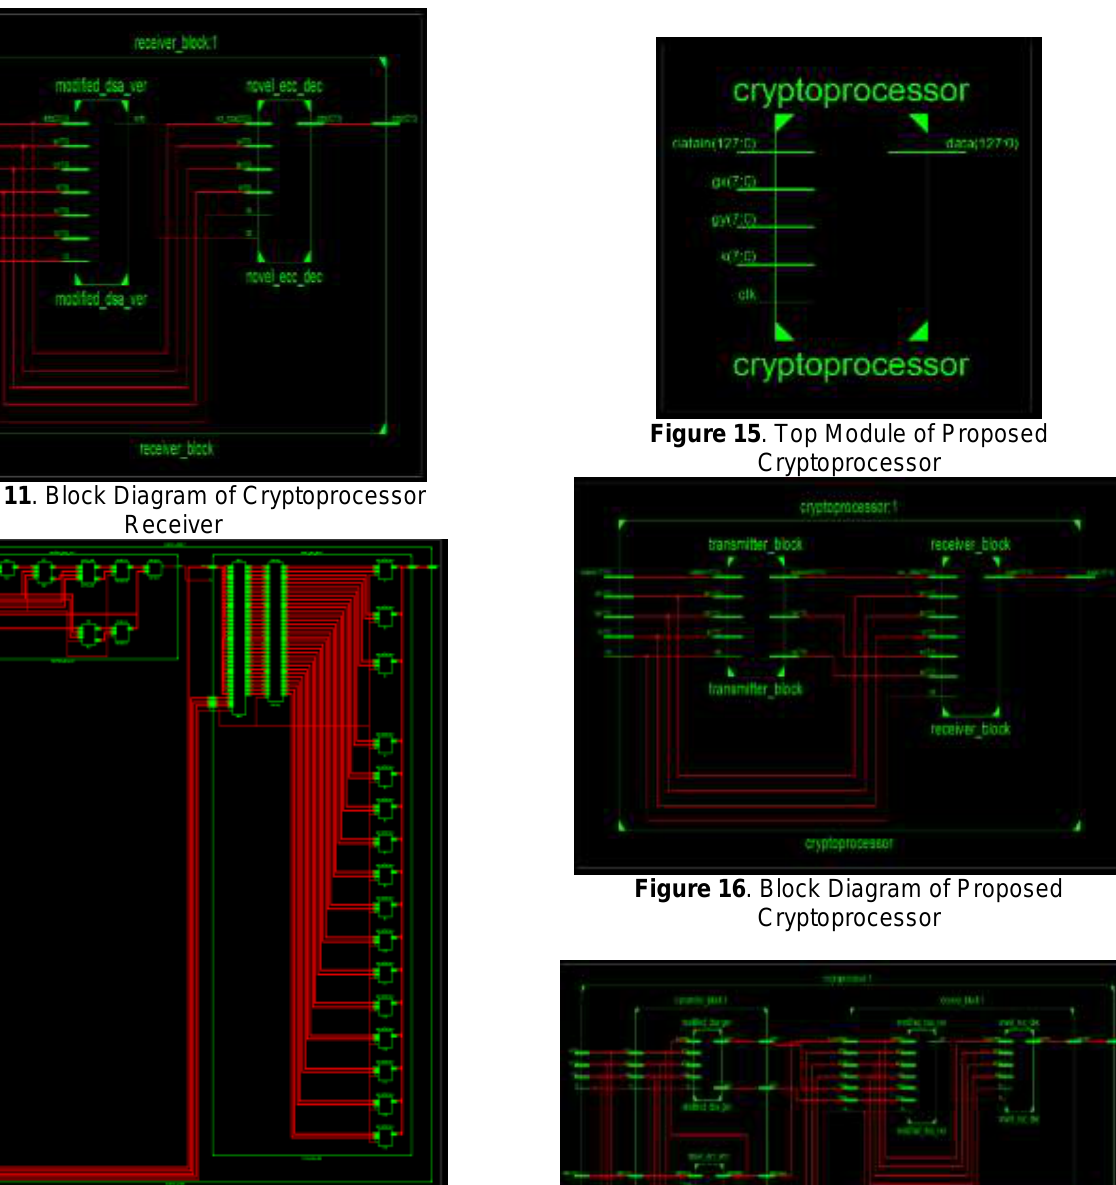
Figure 12 . Expanded Block Diagram of Cryptoprocessor Receiver